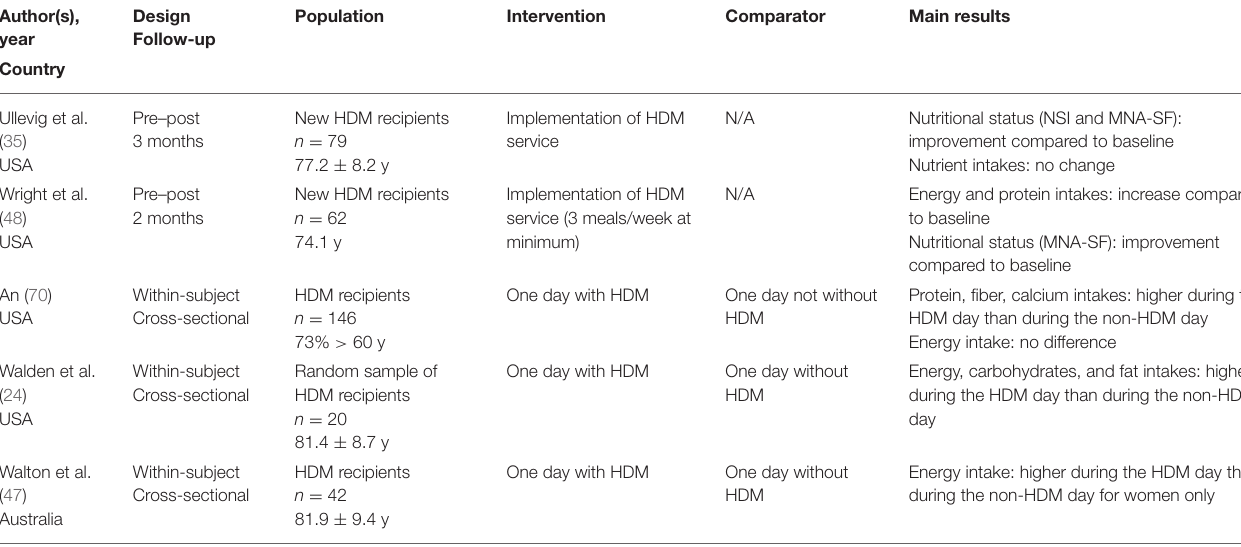
Table 4 ) from assessing the impact of an improved HDM service (e.g., with dietetic counseling, enriched meal) vs. providing a standard HDM service (as we did on Table 5